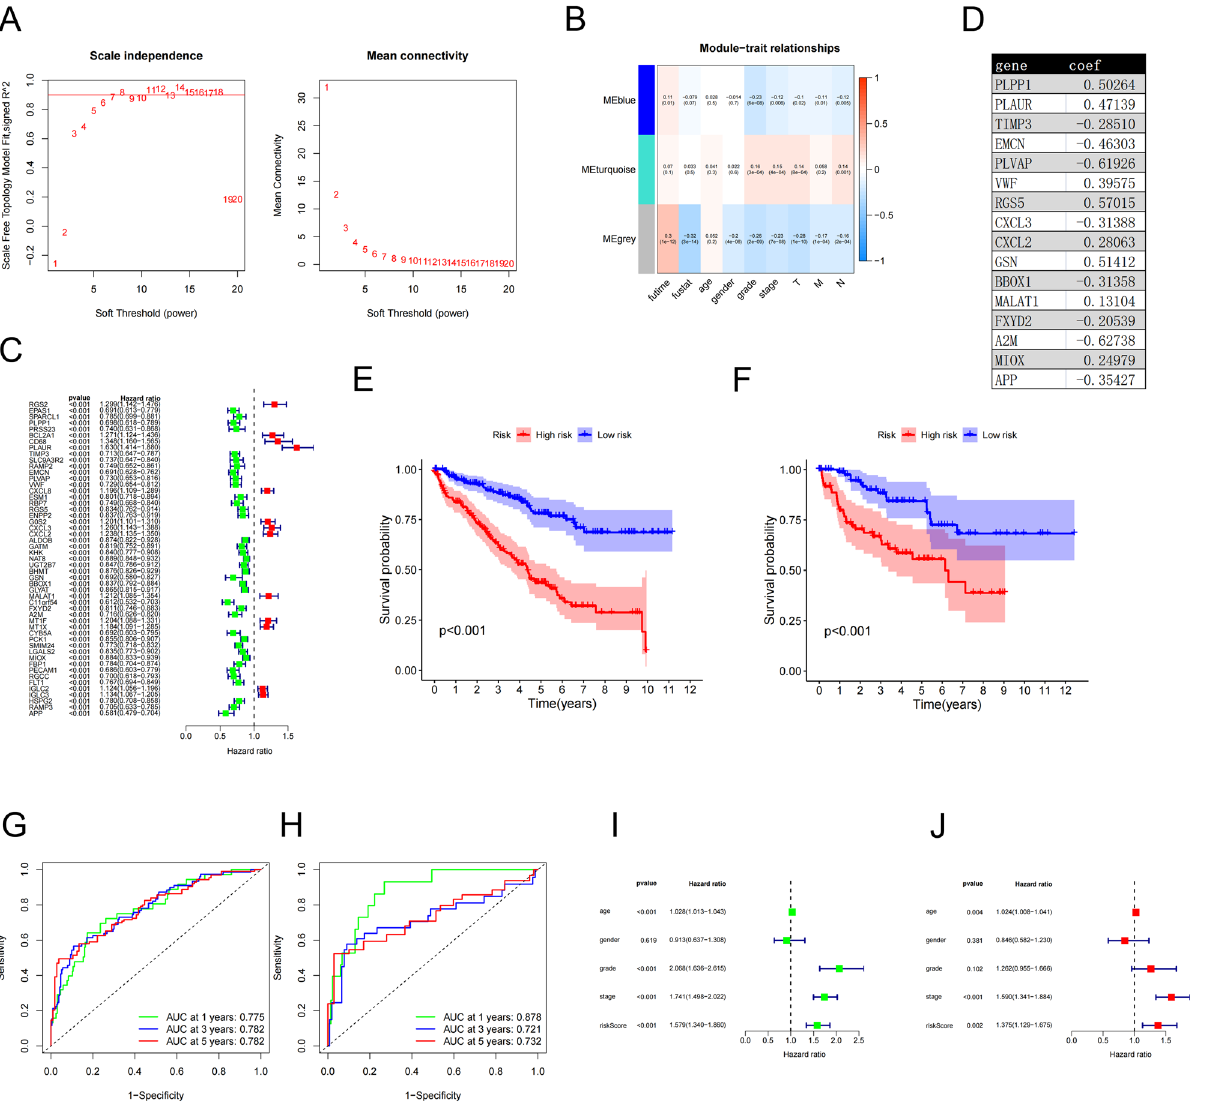
Figure 7. Identification, evaluation, and validation of a prognostic risk signature. ( A,B ) Three modules were accessed with power = 7 based on WGCNA, and the blue module was chosen for further analysis (P (MEblue- futime) < 0.05, P (MEblue-grade) < 0.05). ( C ) A forest plot illustrating the results of univariate analysis of DRGs. ( D ) The genes used to establish the model and their corresponding coefficients. ( E, F ) Kaplan–Meier survival plot displaying the results of survival analysis in the high-risk and the low-risk groups in the train and the test cohorts (the left-sided plot belongs to the train cohort and the right-sided one belongs to the test cohort). ( G, H ) The values of area under the ROC curves for predicting 1-, 3-, and 5-year survival in the train and test cohorts. (the left-sided plot belongs to the train cohort and the right-sided one belongs to the test cohort). ( I ) Univariate analysis of RS and clinicopathological characteristics. ( J ) Multivariate logistic regression analysis of RS and clinicopathological